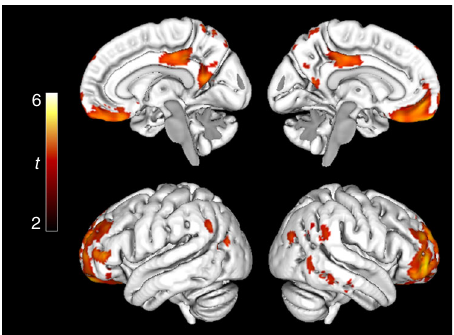
Fig. 5 Replication of the early A β regions in BioFINDER. Comparison of 18 F- fl utemetamol SUVR between early accumulators (CSF+/PET − , n = 30) and non-accumulators (CSF − /PET − , n = 219) in BioFINDER to identify early A β regions. The highest signi fi cance was seen around the posterior regions of the cingulate cortex and the orbitofrontal cortex similar to the results in ADNI (Fig. 1a, b). Note that the BioFINDER analysis included cross-sectional data and fewer subjects compared to ADNI, which results in less statistical power. Voxelwise two-sample t -test was used. The signi fi cance threshold was set at p < 0.001 and the comparison was adjusted for age and gender. The red/yellow colors illustrate signi fi cant t values according to the scale on the